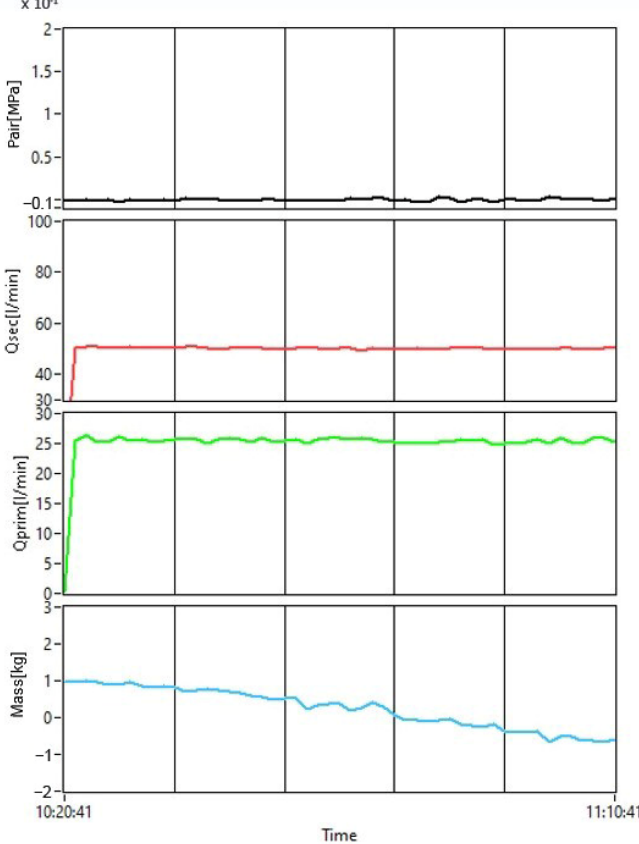
Figure 10. Evolution of pressure, primary and secondary air flow rate, and pellet consumption during the test with primary/secondary air flow rate ratio of 25/50 L/min.